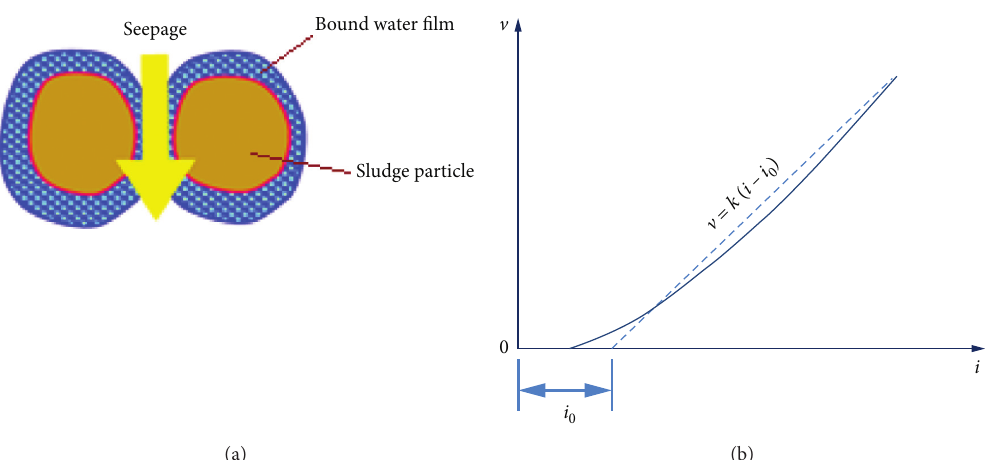
Figure 16: Sludge seepage model. i 0 , initial hydraulic gradient; i , hydraulic gradient;